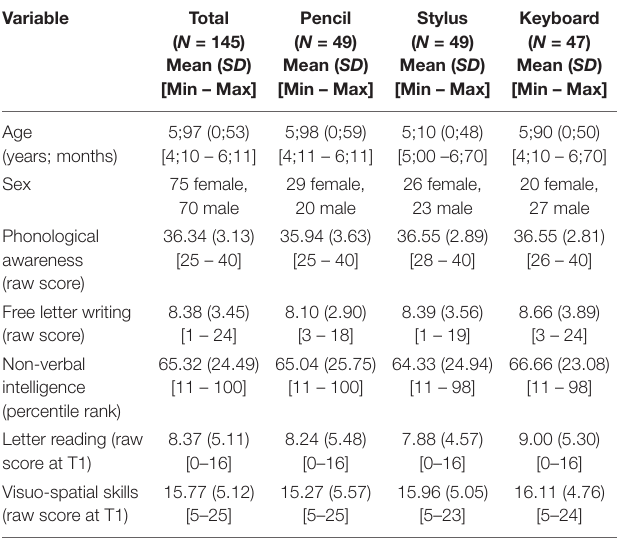
TABLE 1 | Descriptive data of the 145 children on the matching and control variables across the three different conditions. Variable